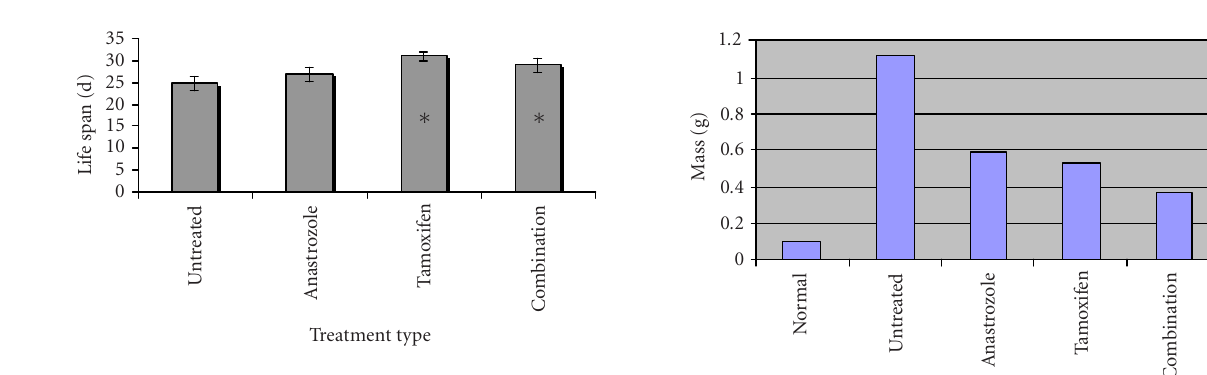
Figure 1. Mean life spans of 4T1-inoculated mice. Stars indi- cate statistical di ff erence from the untreated group ( P ≤ . 05), as determined by the Student t test. Bars represent ± SEM.